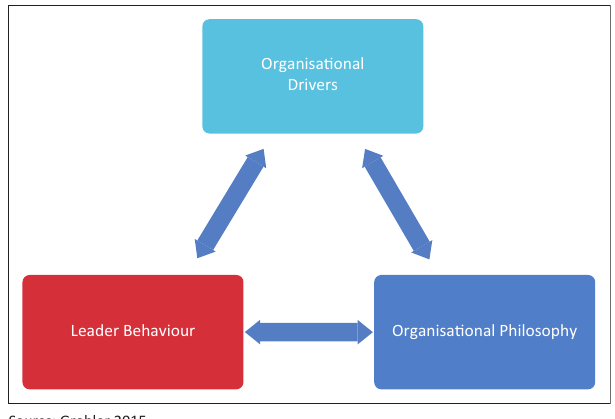
FIGURE 2: Interplay between organisational performance, organisational philosophy and leader behaviour.